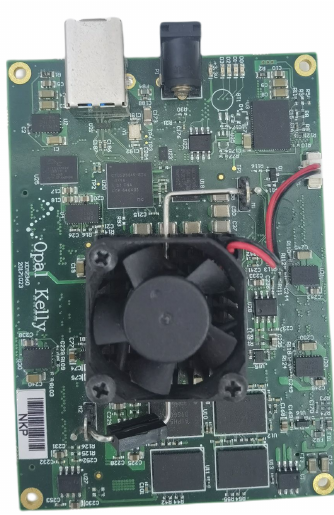
Figure 1. The Xilinx Kintex-7 410T FPGA.